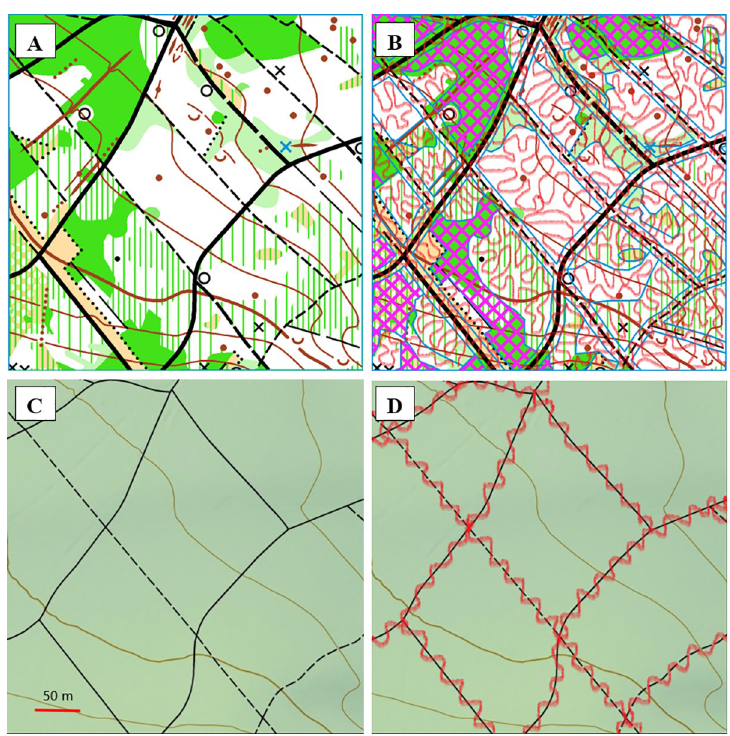
Fig 1. Typical inspection patterns of screening for plant taxa in large forest areas using the O-map/way method or the NT-map/way method. The part shown is a 16.8 ha large area of the target area 710f from the forest “Ko¨nizbergwald” (S1 Table). A and B show the area on the O-map (Reprinted from O-map “Ko¨nizberg”, #299 Q, under a CC BY license, with permission from OLG Bern, original copyright 2013) and C and D show the area on the NT-map (Reprinted from Landeskarte der Schweiz, #1166, 2012, no license needed, with permission for reproduction from swisstopo, 2019). A and C show the corresponding original map parts; B and D show in a schematic way the meandering inspection routes (in red), in B along and between all ways, and in D along only NT-ways. In B, reduced accessible areas are shown as crossed lines in magenta. Features are explained for O-maps by IOF, [7], for NT-maps, by swisstopo,